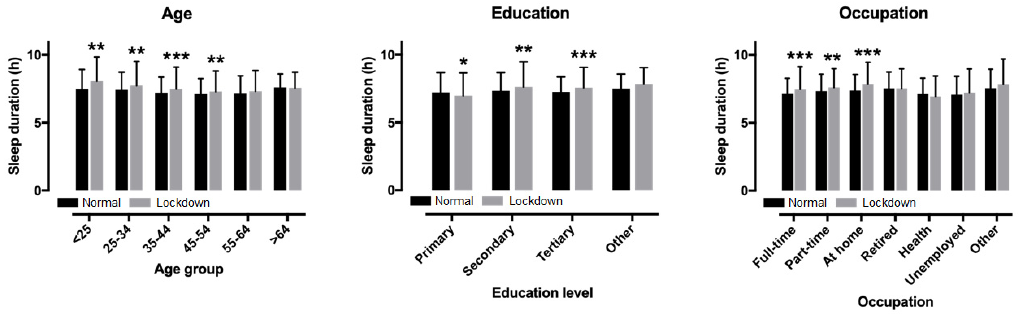
Figure 2. Changes in sleep duration from normal to the lockdown week by age, education, and